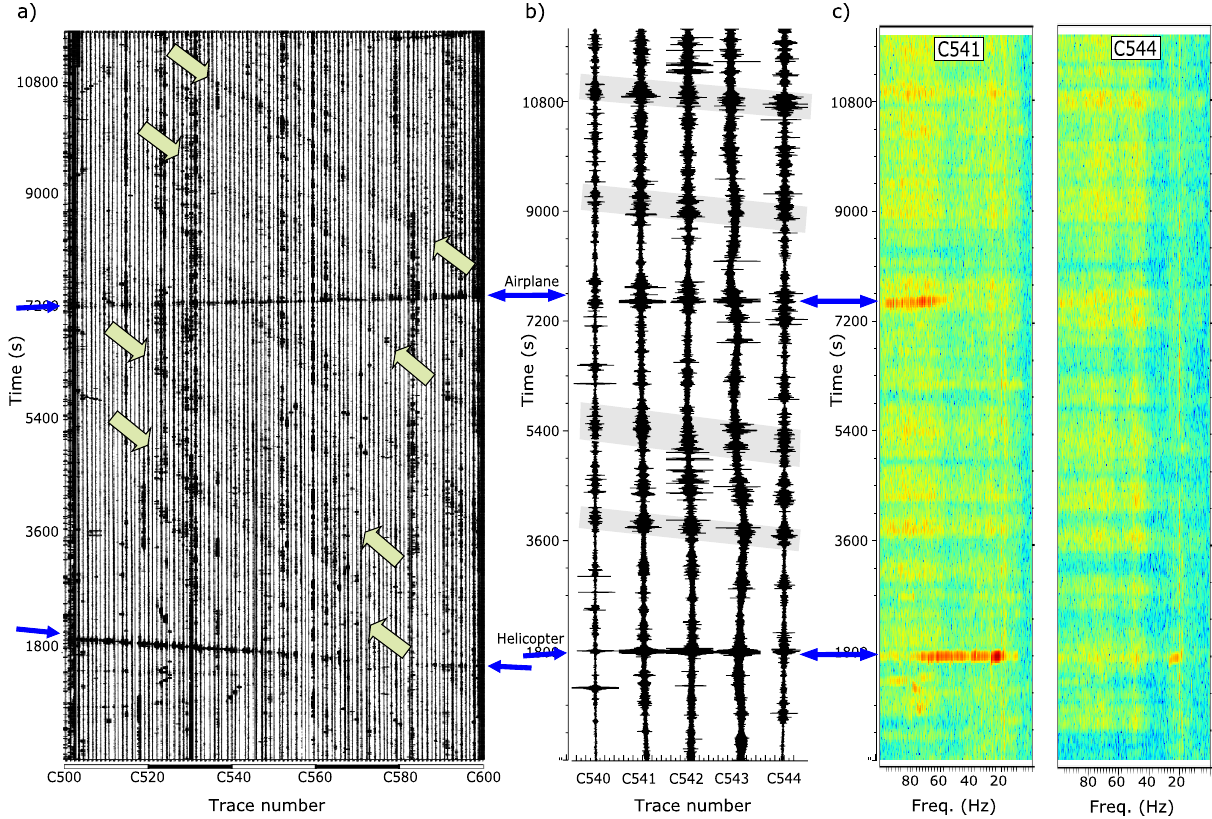
Figure 8. ( a ) Raw data for stations C500-C600, including the helicopter and airplane signals discussed in previous sections (thin blue arrows). Thick green arrows mark some examples of the wind gusts. ( b ) Subset of traces C540–C544 showing with grey boxes some of the wind gusts. ( c ) Spectrograms for traces C541 and C544), separated by 1.3 km. Intervals with blowing winds appear as bands of increased energy, better identified at frequencies above 20–40 Hz (color scale as in Figs. 3 and